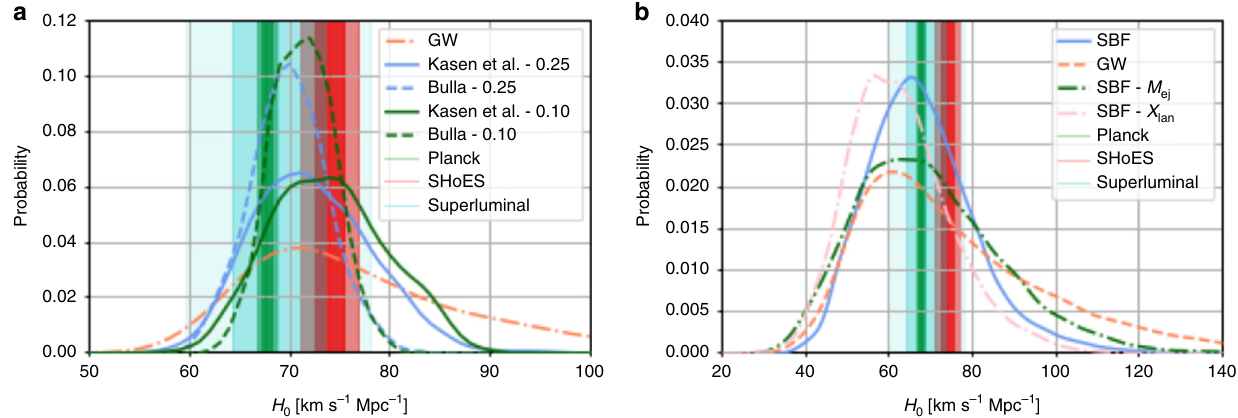
Fig. 2 Summary of posterior distributions for H 0 . In a , we show the GW-only analysis for GW170817, in addition to the Kasen 24 and Bulla 25 model analyses with 0.1 mag and 0.25 mag errors from this letter. In addition, the 1- and 2- σ regions determined by the superluminal motion measurement from the radio counterpart (blue) 16 , Planck CMB (TT,TE,EE + lowP + lensing) (green) 34 , and SHoES Cepheid-SN distance ladder surveys (orange) 5 are also depicted as vertical bands. In b , we use GRB 060614 and the Kasen 24 model with 0.1 mag errors. In addition to the standard SBF measurement in the letter, we show an analysis where we systematically add 0.1 M ⊙ to M ej and 0.5 decades to X lan . Finally, we show a distribution where we replace the standard SBF measurement with the distance measurement from the GW170817 high spin posteriors.